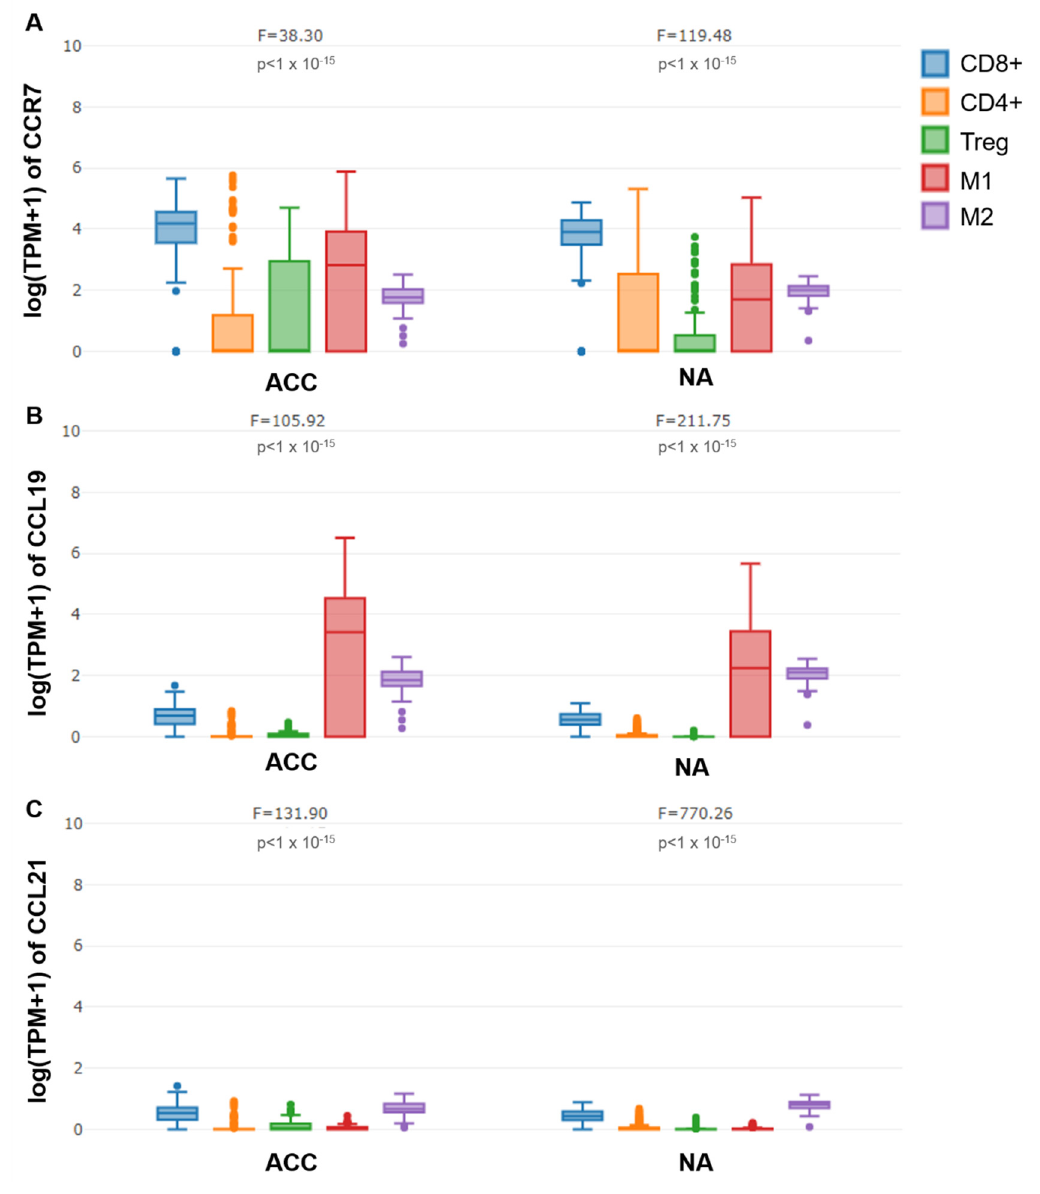
Figure 4. Comparison of CCR7 ( A ), CCL19 ( B ), and CCL21 ( C ) mRNA expression between CD8+, CD4+, and regulatory T cells, as well as M1 and M2 macrophages using publicly available datasets for adrenocortical carcinoma (ACC) and normal adrenal glands (NA). (GEPIA2021, sub-expression analysis, http://gepia2021.cancer-pku.cn/, accessed 22 August 2021; CIBERSORT deconvolution tool, one-way ANOVA).